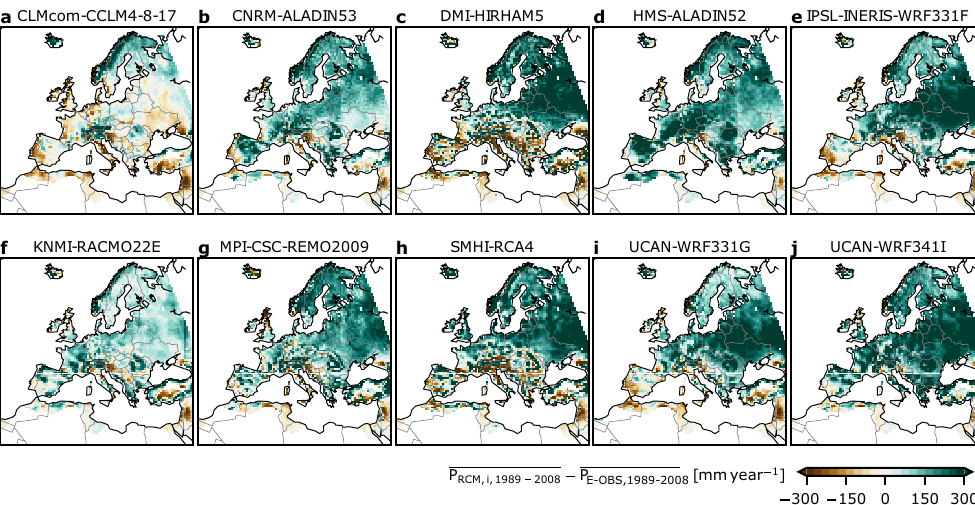
Figure 1. Example for precipitation biases. Differences of long-term mean (1989 to 2008) annual sums of the individual EURO-CORDEX ensemble RCMs used in this study and E-OBS gridded observations [mm year −1 ]. A common mask is applied to ensure a spatial overlap between RCMs and E-OBS. Data is shown on the native EURO-CORDEX 0.44° degree resolution EUR-44 grid. The Med-CORDEX model domain (not shown) encompasses the Mediterranean area from about 10 W to 50 E and 25 N to 60 N in the Southern part of the pan-European EURO-CORDEX